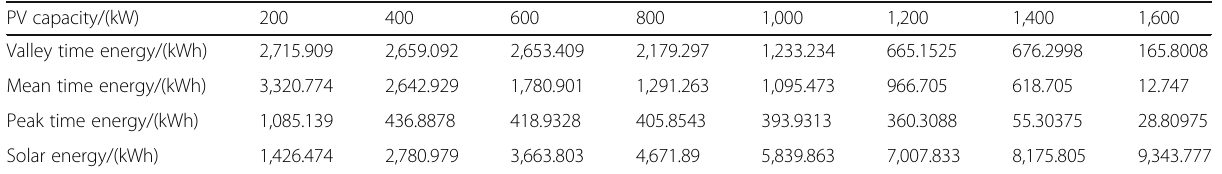
Table 6 The energy consumption distribution of BSS with different PV capacities (PV bundling requirement = 80%) PV